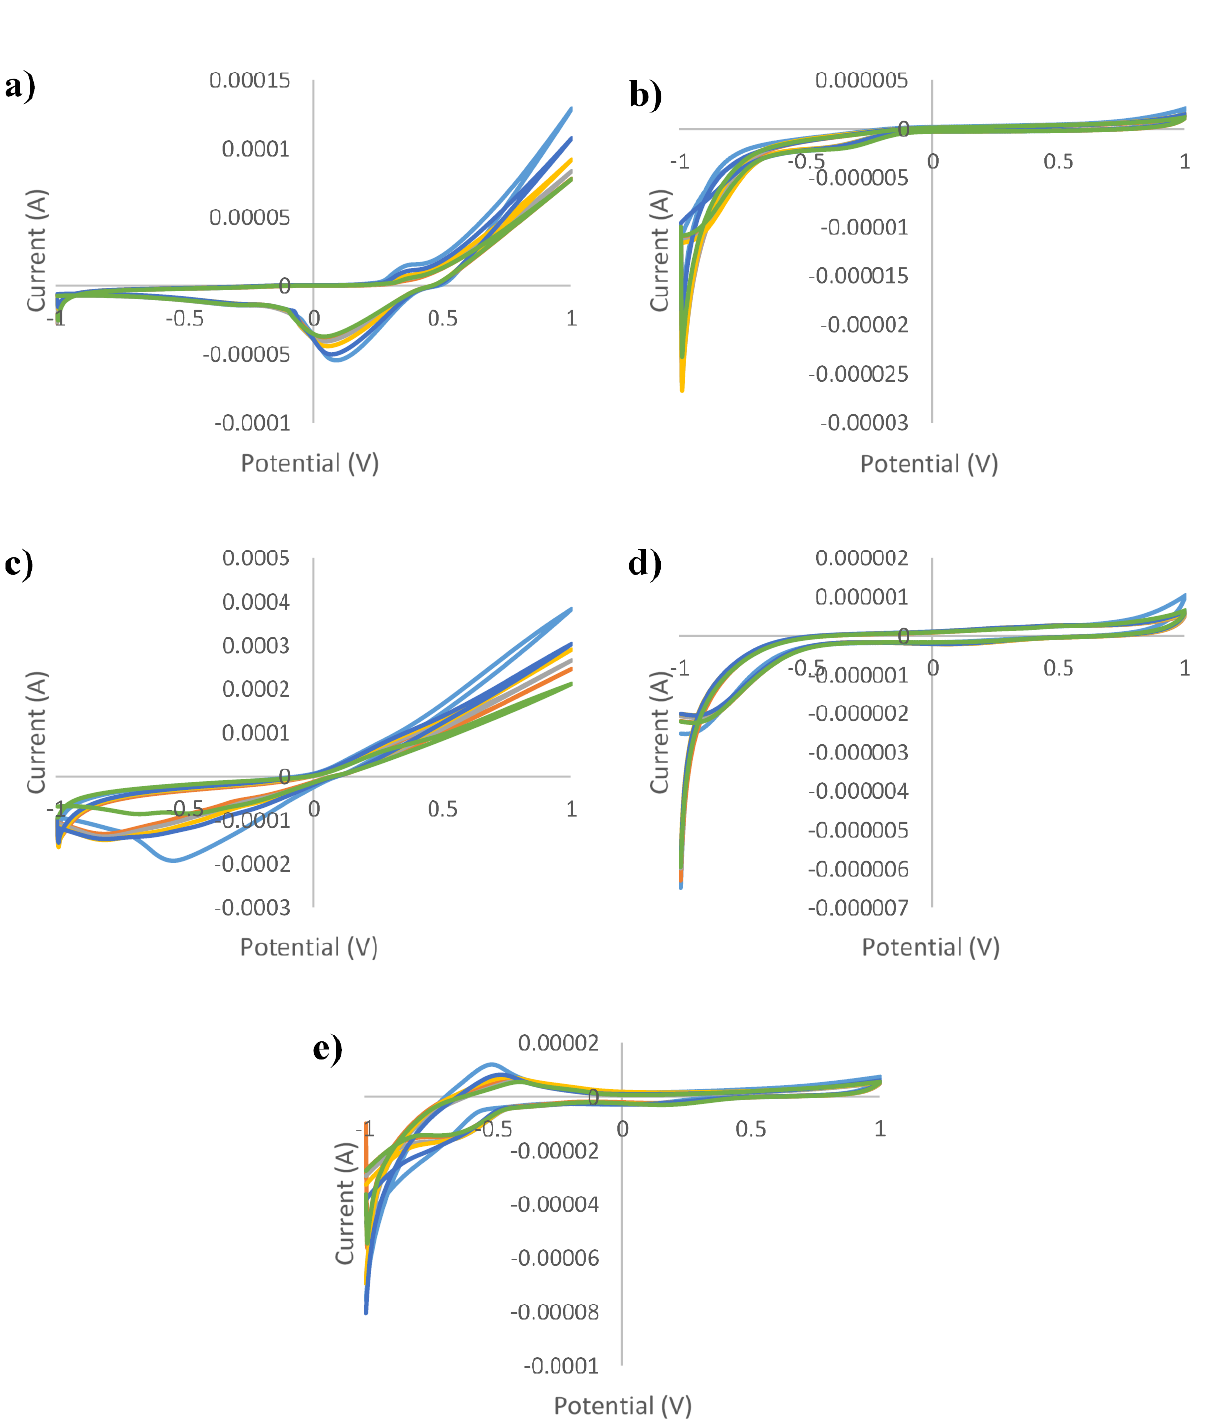
Figure 3. Cyclic voltammograms of authentic and adulterated (with rice syrup) tilia honey solutions for: ( a ) silver electrode; ( b ) gold electrode; ( c ) copper electrode; ( d ) glass electrode; ( e ) platinum electrode and green line—authentic honey; light blue line—agave syrup; red line—honey adulteration 5%; gray line—honey adulteration 10%; orange line—honey adulteration 20%; dark blue—honey adulteration 50%.